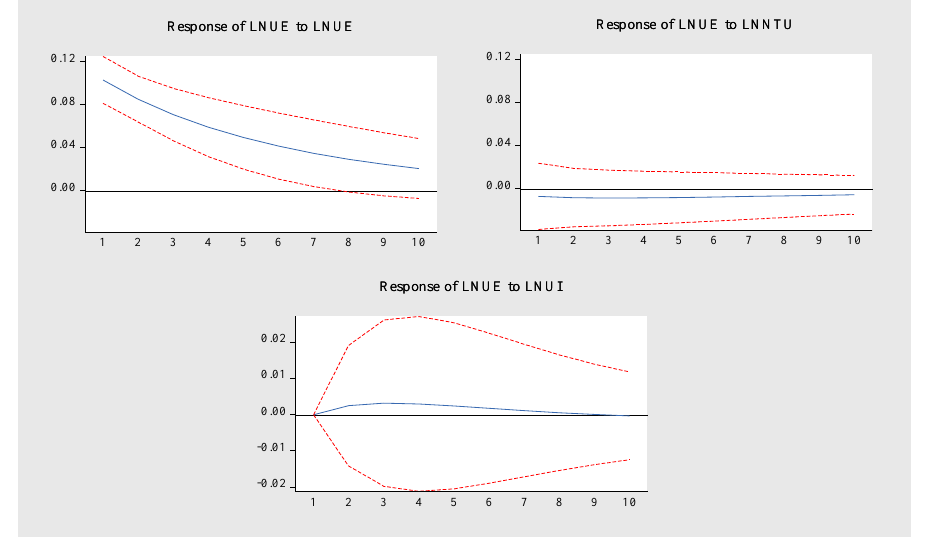
Figure 11. Pulse response diagram of LNUE.